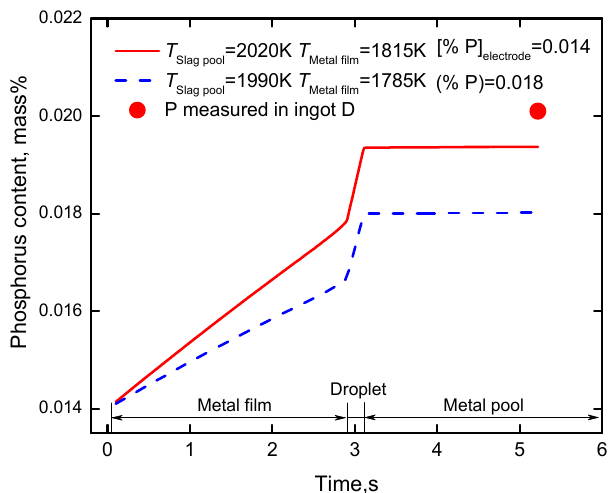
Figure 10. E ff ect of temperature of slag pool on P content in ingots under the same P in electrode and slag.